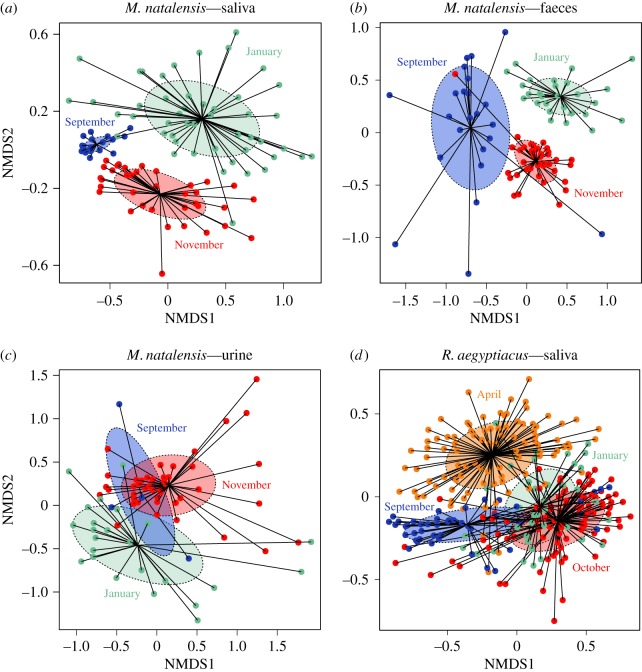
Shift of microbiota composition over the reproductive season in (a–c) M. natalensis and (d) R. aegyptiacus. Each data point represents the microbiota from one bat. Shaded ellipses represent one standard deviation around sample group centroids.